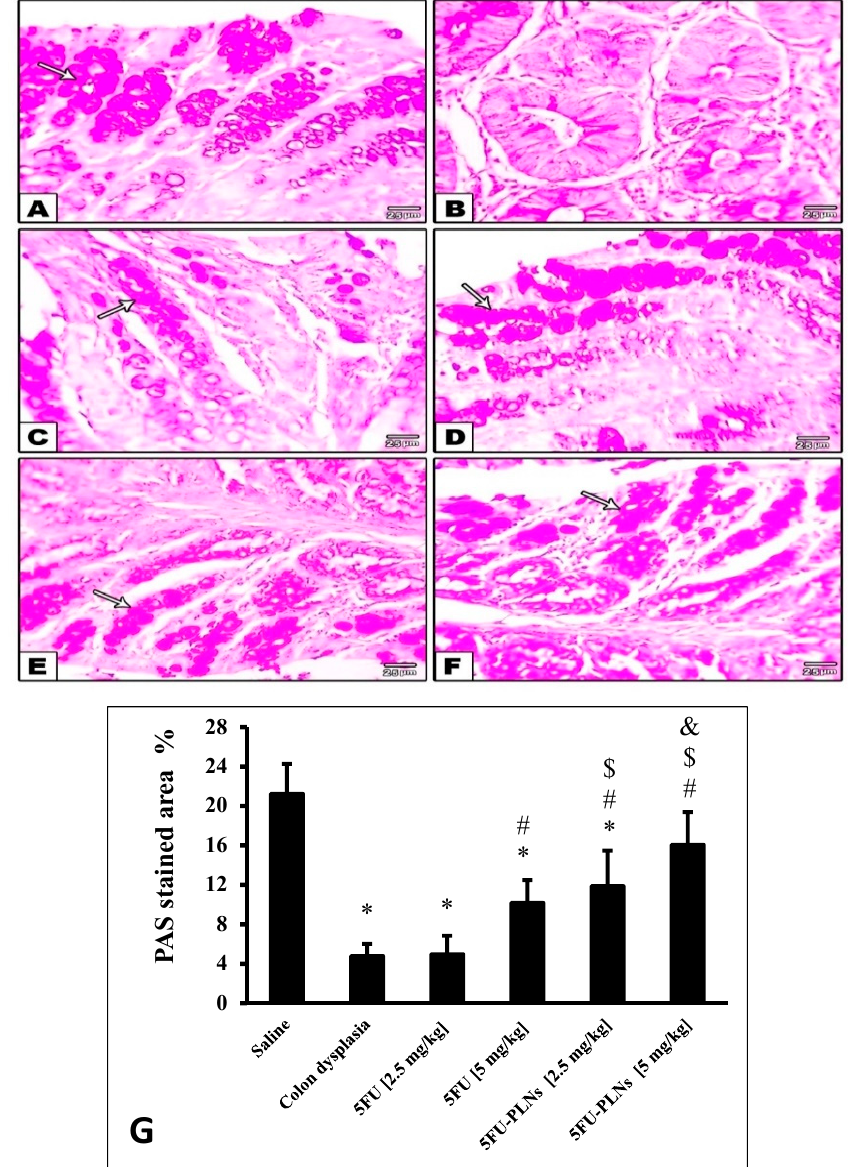
Figure 8. Microscopic pictures of periodic-acid Schiff stained colonic sections. Images show normal density of goblet cells (arrows) lining the crypts in the saline control group ( A ). Colon hyperplasia control group showed marked decrease of goblet cells in dysplastic crypts ( B ). Mice groups treated with free 5FU [2.5 or 5 mg/kg] ( C , D ) showed increased goblet cell density. Density of goblet cells appeared higher in groups treated with 5FU-PLNs [2.5 mg/kg] ( E ) and 5FU-PLNs [5 mg/kg] ( F ) X400. ( G ) Area of periodic acid Schiff staining presented as mean ± SDM and compared at p less than 0.05. *: Versus saline group; # : Versus colon dysplasia group; $: Versus 5FU [2.5 mg/kg] group; &: Versus 5FU [5 mg/kg] group.